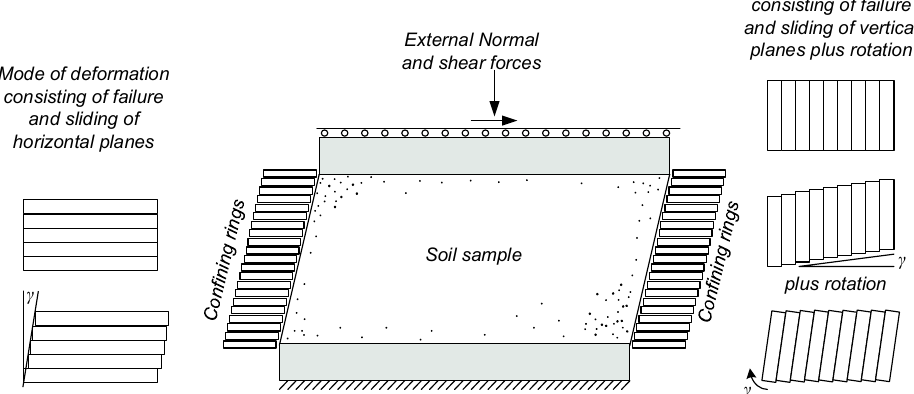
Figure 1. Illustration of the direct simple shear test and possible kinematically compatible modes of deformation (following [44,45]).